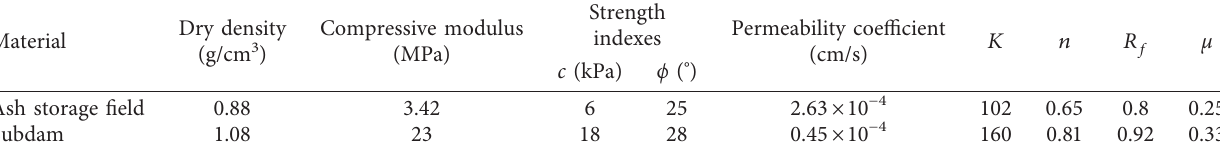
Figure 3: Geometric model for numerical computation. Table 3: Model parameters for static computation.